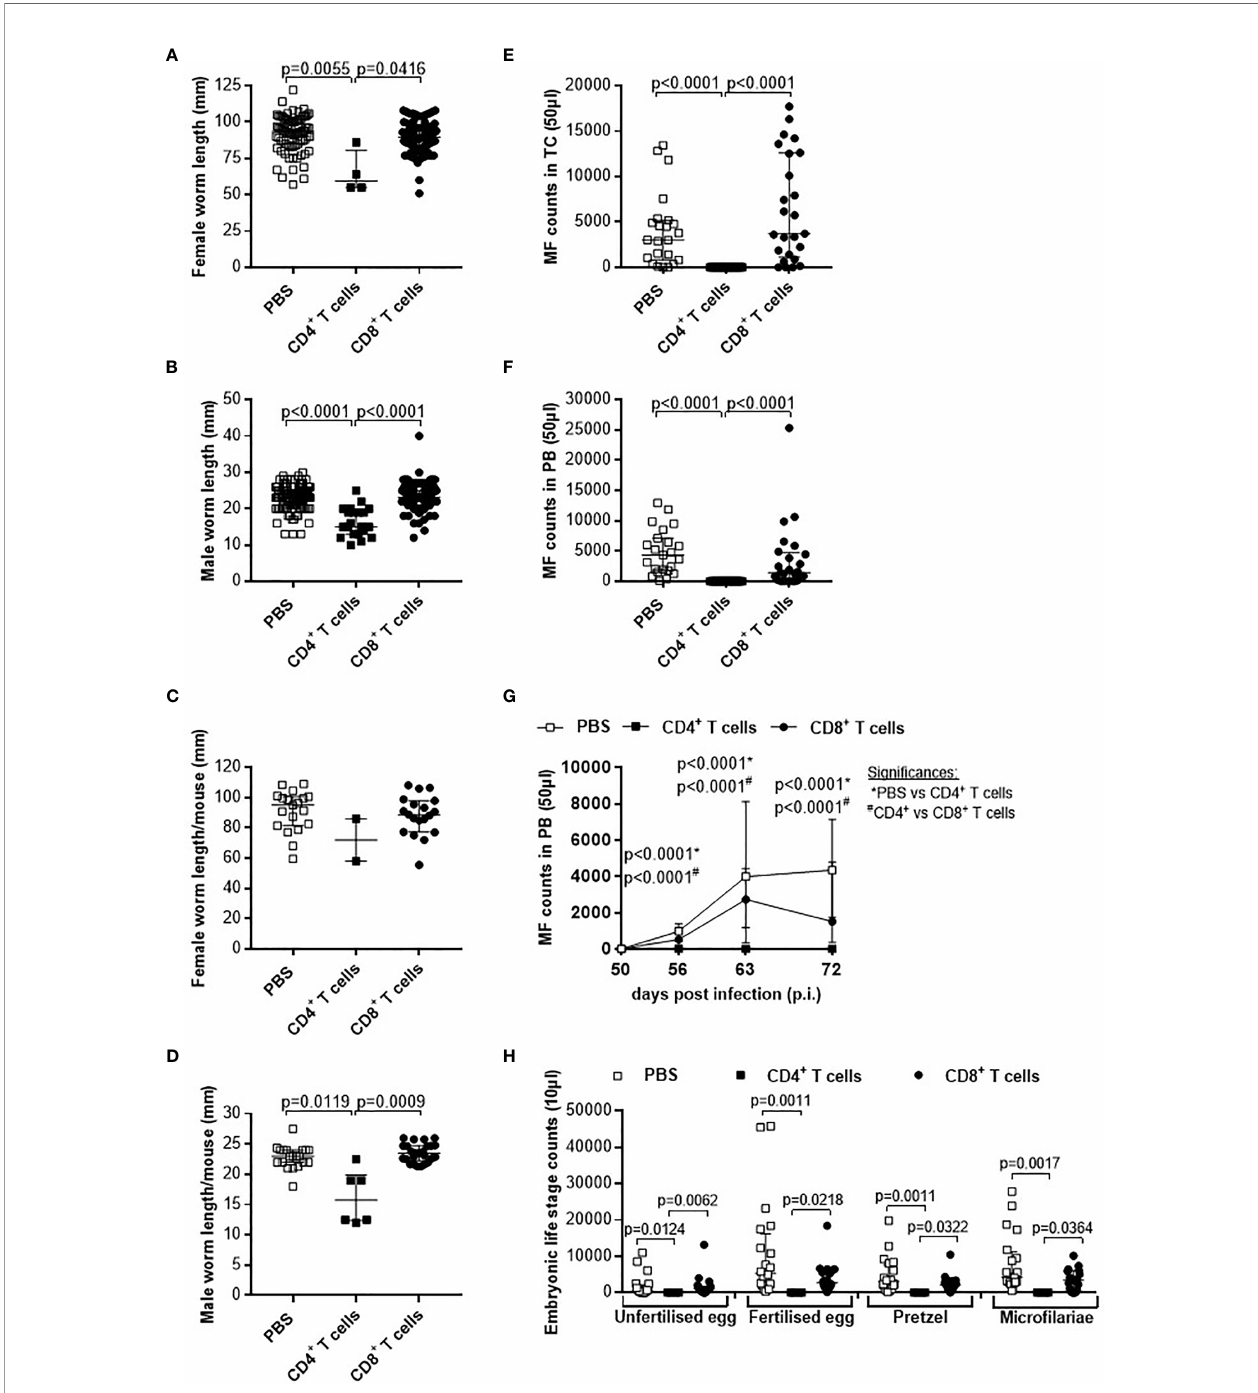
FIGURE 5 | Adoptive transfer of CD4 + T cells from L. sigmodontis -infected C57BL/6 mice impair worm growth and blocks micro fi laria release and development of embryogenic stages. On day 72 p.i., RAG2IL-2R g -de fi cient C57BL/6 mice that were adoptively transferred with CD4 + or CD8 + T cells isolated from L. sigmodontis - infected C57BL/6 mice 28 days p.i. were analysed for individual (A) female and (B) male worm length and (C) female and (D) male worm length per mouse. In addition, micro fi laria (MF) counts were determined in the (E) thoracic cavity (TC) and (F) peripheral blood (PB) and (G) during the course of infection in PB upon 50 days p.i. Moreover, female adult worms were analysed to determine (H) embryonic stages. Graphs show dot blots with median and interquartile ranges from individual mice from (A – G) three independent experiments including no adoptive transfer (PBS; n=23) and adoptive transfer of CD4 + (n=21) and CD8 + T cells (n=25) into RAG2IL-2R g -de fi cient C57BL/6 mice. (H) Results are from one experiment including n=20, n=4 and n=20 individual worms from no adoptive transferred (PBS; n=7) and CD4 + (n=2) and CD8 + T cell (n=8) adoptive transferred RAG2IL-2R g -de fi cient C57BL/6 mice, respectively. Signi fi cant differences between the groups were determined by Kruskal-Wallis-test followed by a Dunn ’ s multiple comparison